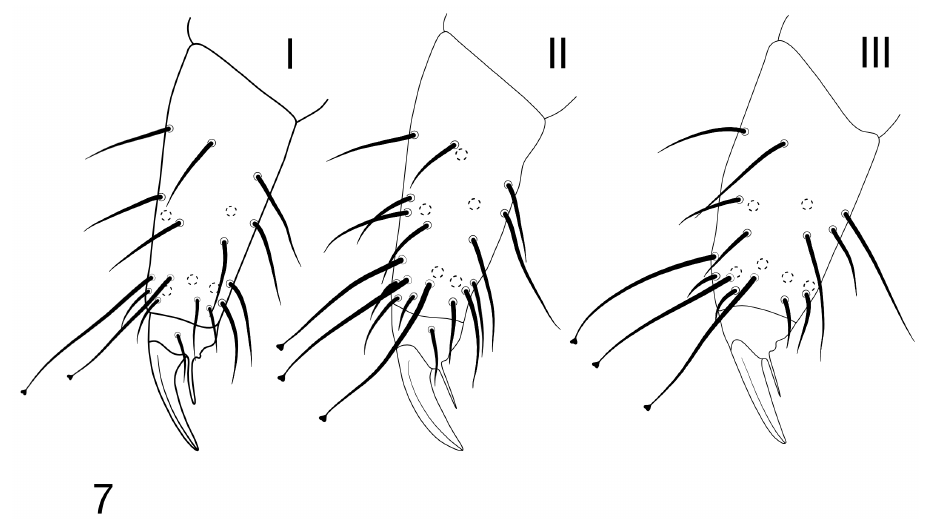
Figure 7. Chribellphorura allanae : Tibiotarsi and claws of legs I–III. Redescription. Length up to 2.0 mm, specimen examined (female) 1.3 mm.